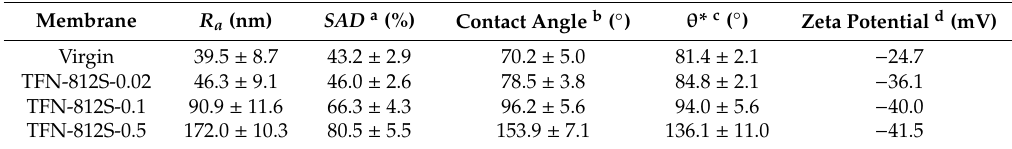
Figure 10. Contact angles of the membranes with different concentrations of NPs. Table 4. Surface properties of the TFC and TFN RO